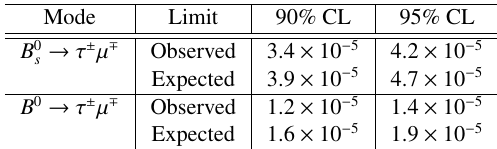
Table 2: Expected and observed 90% and 95% CL limits on the B d , s → τµ branching